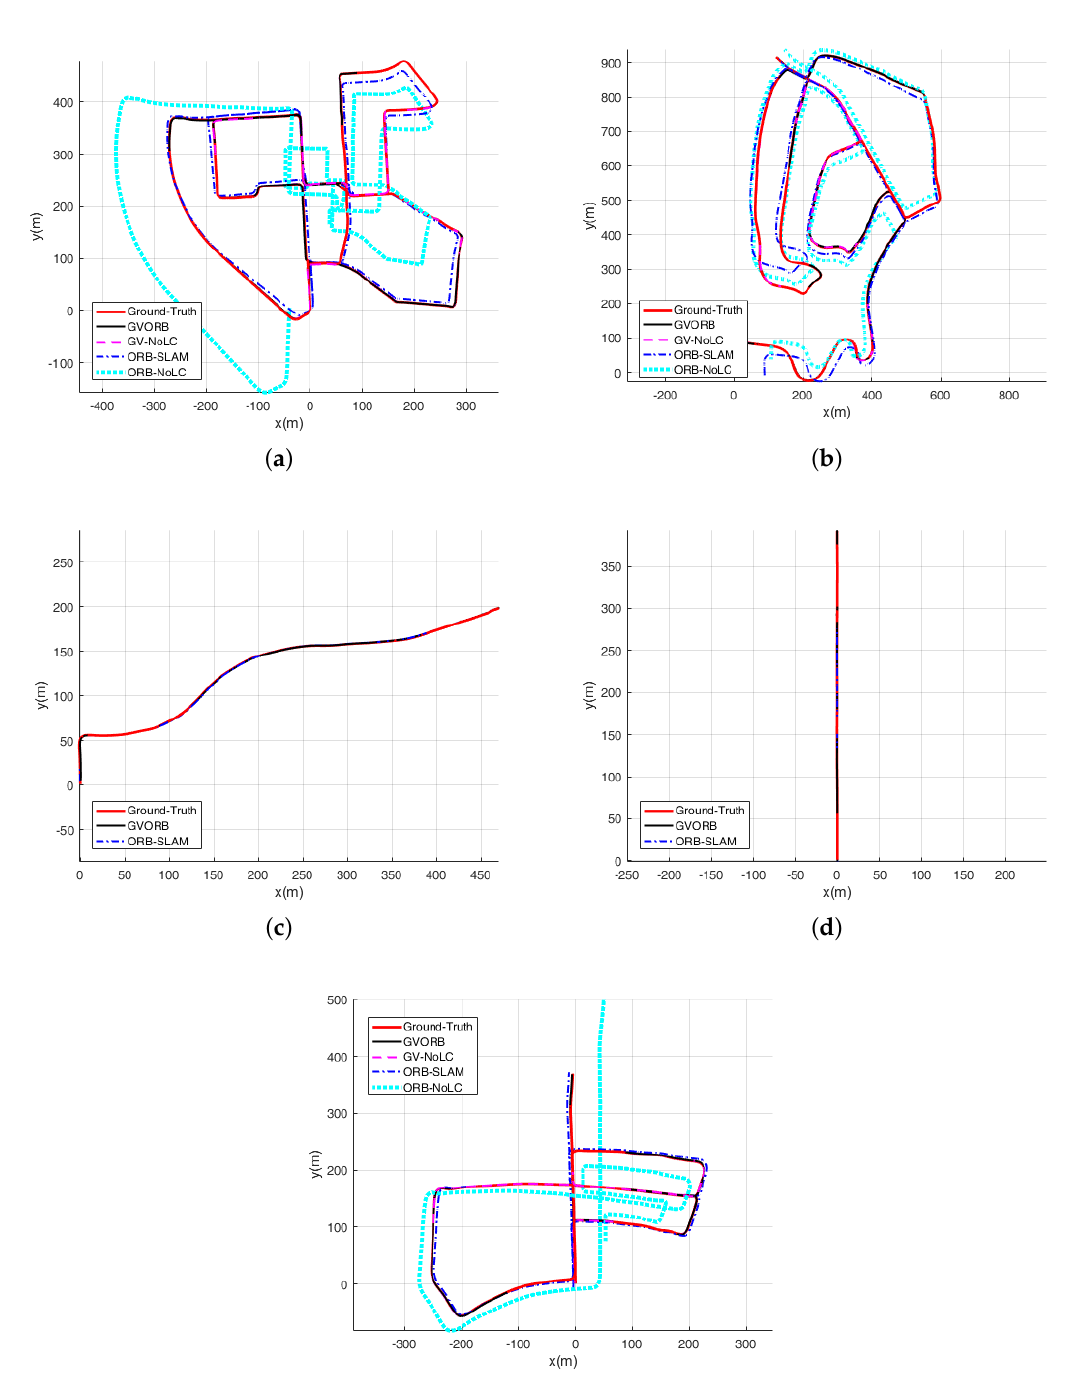
Figure 8. The localization results using the KITTIdataset. The subfigures correspond to sequences 00 and 02–05: ( a ) Sequence 00; ( b ) Sequence 02; ( c ) Sequence 03; ( d ) Sequence 04; ( e ) Sequence